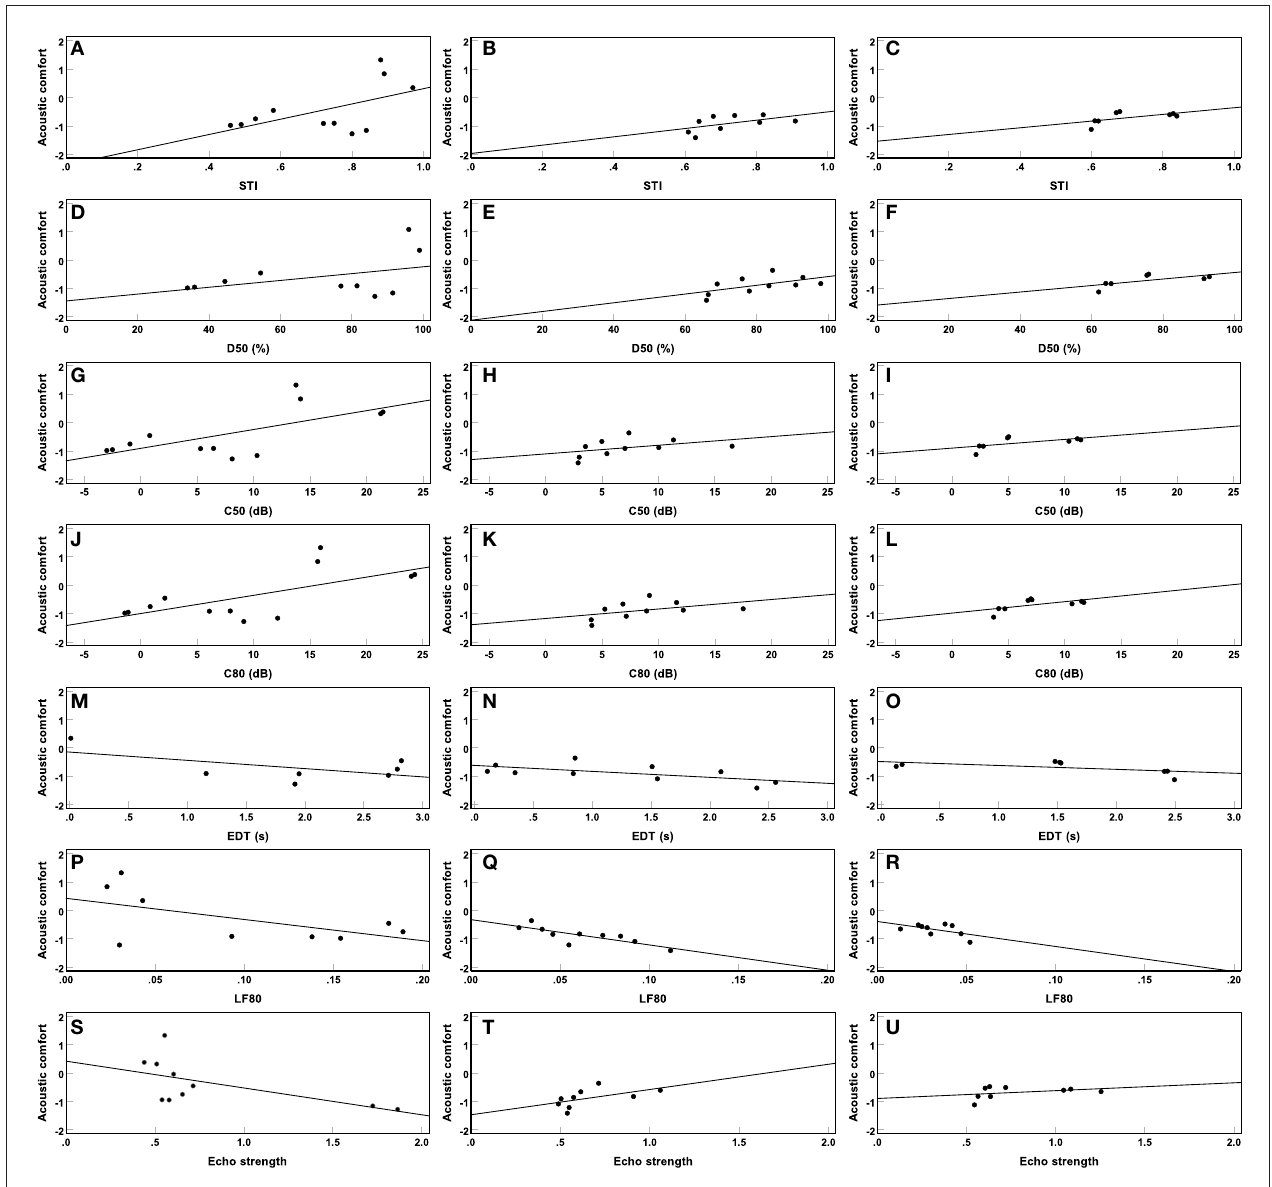
FIGURE 8 | Scatter plots showing mean acoustic comfort ratings across subjects and sound sources as a function of the individual room acoustical parameters. The lines indicate simple linear regressions based on the respective room acoustical parameters. The left panel (i.e., A,D,G,J,M,P,S ), the middle panel (i.e., B,E,H,K,N,Q,T ), and the right panel (i.e., C,F,I,L,O,R,U ) show the results of Experiments 1, 2, and 3,